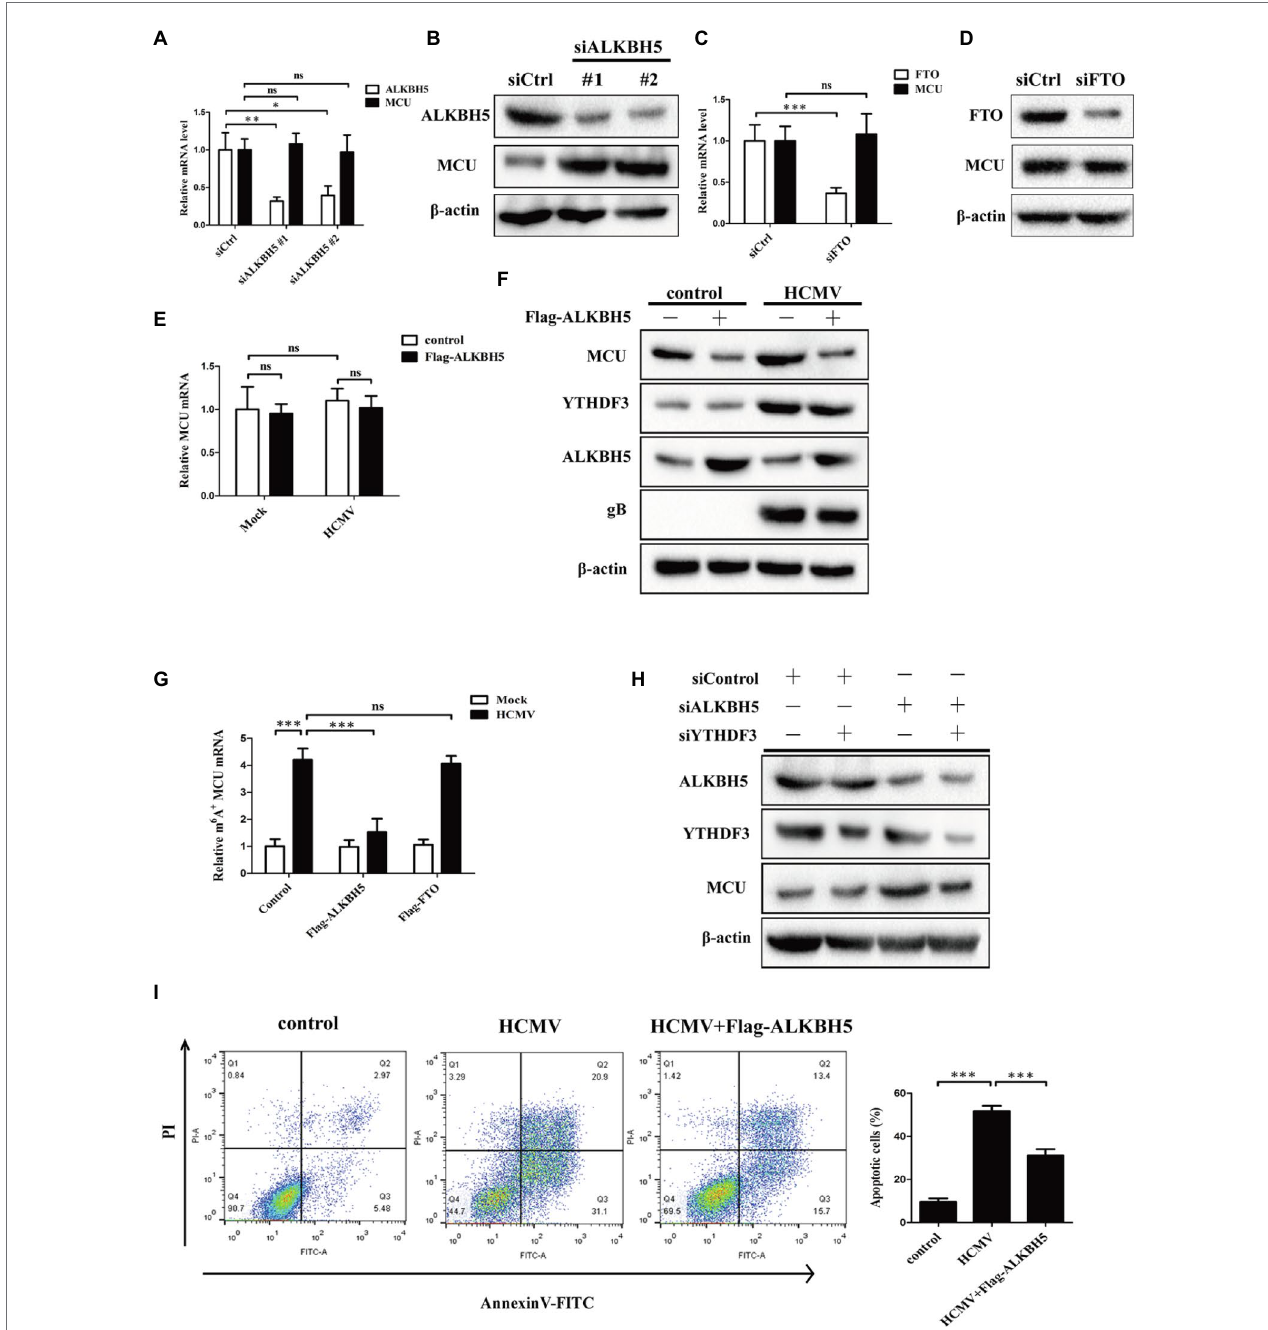
FIGURE 7 | ALKBH5, but not FTO, reverses HCMV-mediated m6A modification of MCU mRNA in HAECs. (A) qRT-PCR analysis of MCU mRNA expression in HAECs with or without ALKBH5 knockdown. Samples were normalized to GAPDH mRNA. (B) Representative Western blotting of MCU in HAECs with or without ALKBH5 knockdown. (C) qRT-PCR analysis of MCU mRNA expression in HAECs with or without FTO knockdown. Samples were normalized to GAPDH mRNA. (D) Representative Western blotting of MCU protein expression in HAECs with or without FTO knockdown. (E) qRT-PCR analysis of MCU mRNA expression in HAECs with or without ALKBH5 overexpression under mock-infected or HCMV-infected condition. (F) Representative Western blotting of MCU protein expression in HAECs with or without ALKBH5 overexpression under mock-infected or HCMV-infected condition. (G) m6A immunoprecipitation and qRT-PCR were performed to identify changes in MCU mRNA that underwent m6A methylation modification in HAECs with or without overexpression of ALKBH5 or FTO under mock-infected or HCMV-infected condition. (H) Western blotting analysis was performed to determine whether the effect of ALKBH5 on MCU protein expression was dependent on the promotion of MCU translation by YTHDF3. (I) Annexin-V/PI double-labeled flow cytometric assay shows that ALKBH5 overexpression attenuates the apoptosis induced by HCMV. Left, representative images of flow cytometry; right, statistical charts. All data are expressed as the mean ± SD of triplicate experiments. Values of p were calculated with student’s t- test, * p < 0.05, ** p < 0.01, and *** p < 0.001. ns: no significant